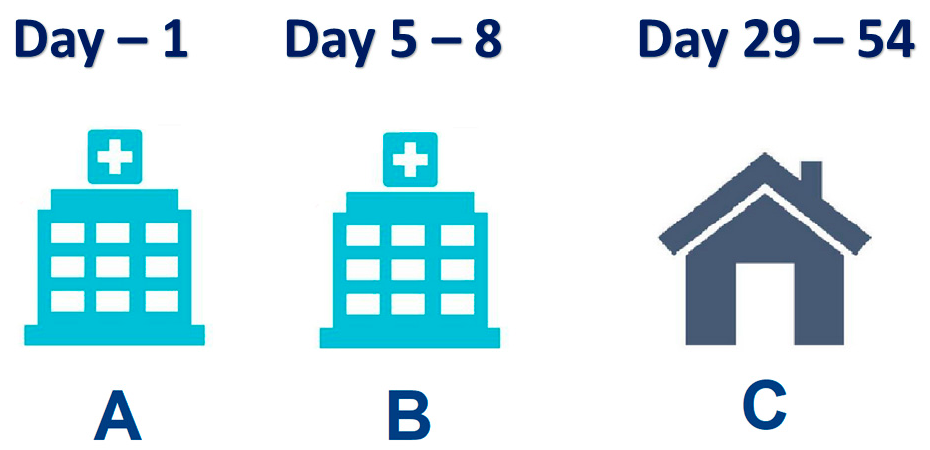
Figure 1. Timepoints of urine sampling from the COVID-19 patients. Table 1. Characteristics of patients enrolled in the study.